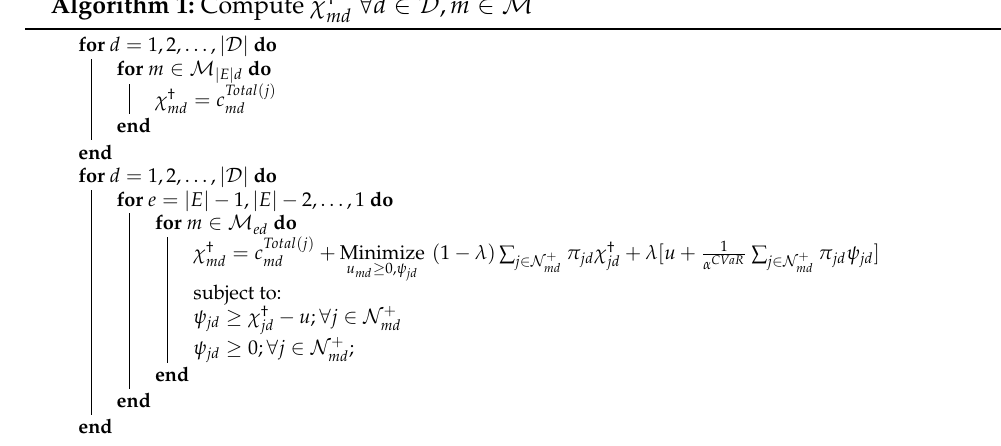
Algorithm 1: Compute χ †